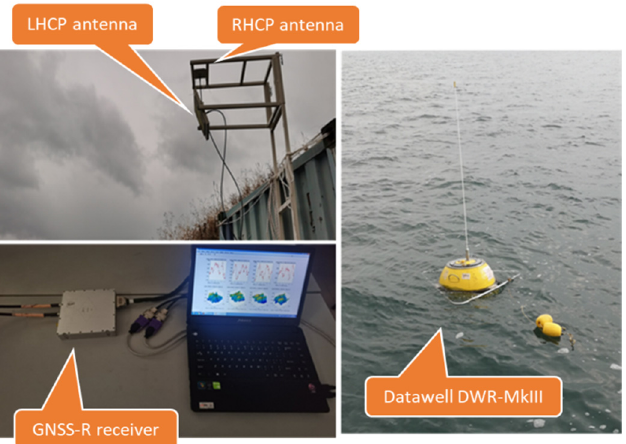
Figure 4. GNSS-R installation, including the antennas and receiver. The RHCP (right hand circularly polarized) antenna and LHCP (left hand circularly polarized) antenna were installed on a bracket and were connected to the receiver by two RF cables. The right part is a view of Datawell DWR-MkIII.